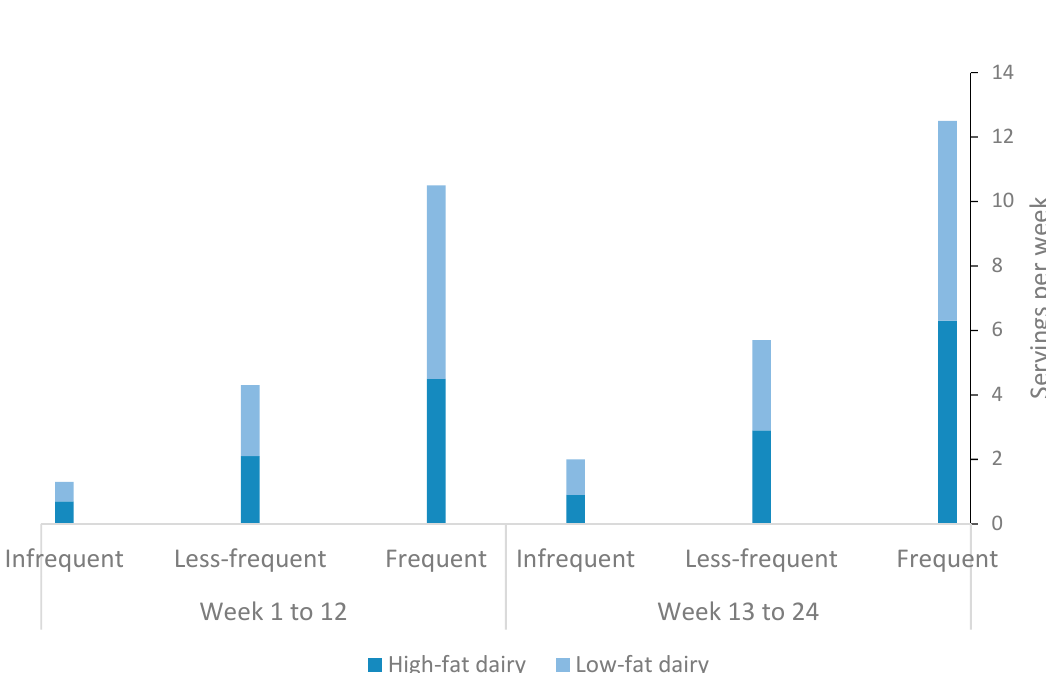
Figure 2. Weekly average dairy consumption and its fat content among study subjects during the intervention phase (week 1 to 12) and the maintenance phase (week 13 to 24).